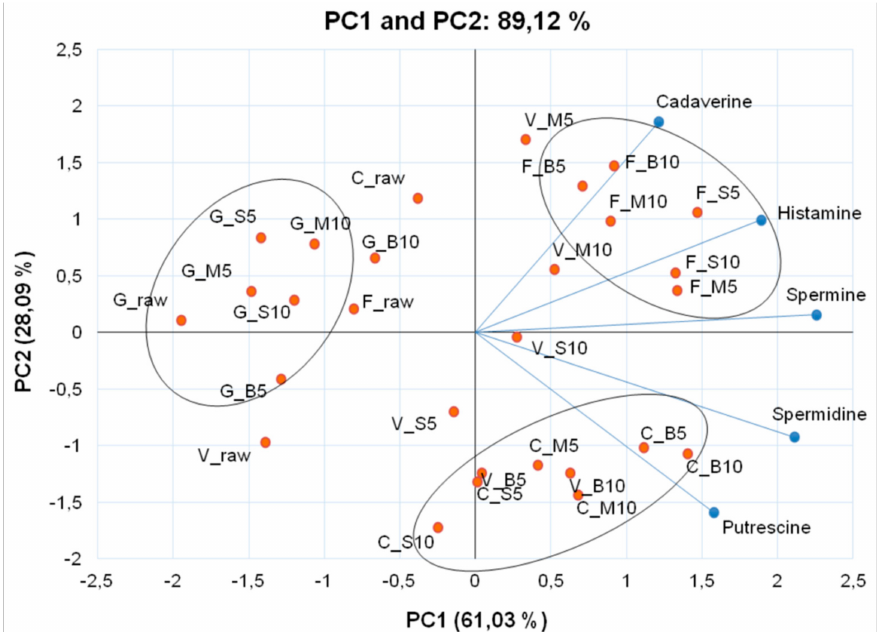
Figure 3. Bi-dimensional projection and biogenic amine scores (cadaverine, histamine, spermidine, spermine and putrescine) in thermally processed colored cauliflowers. The treatments are represented by the points, where initial letters represent the genotypes (V = ‘Verde di Macerata’, G = ‘Gra ffi ti’, F = ‘Forata’ and C = ‘Cheddar’) and the letters after underline represent the cooking methods (raw, B = boiling, S = steam and M = microwave) and the numbers represent cooking times (5 and 10